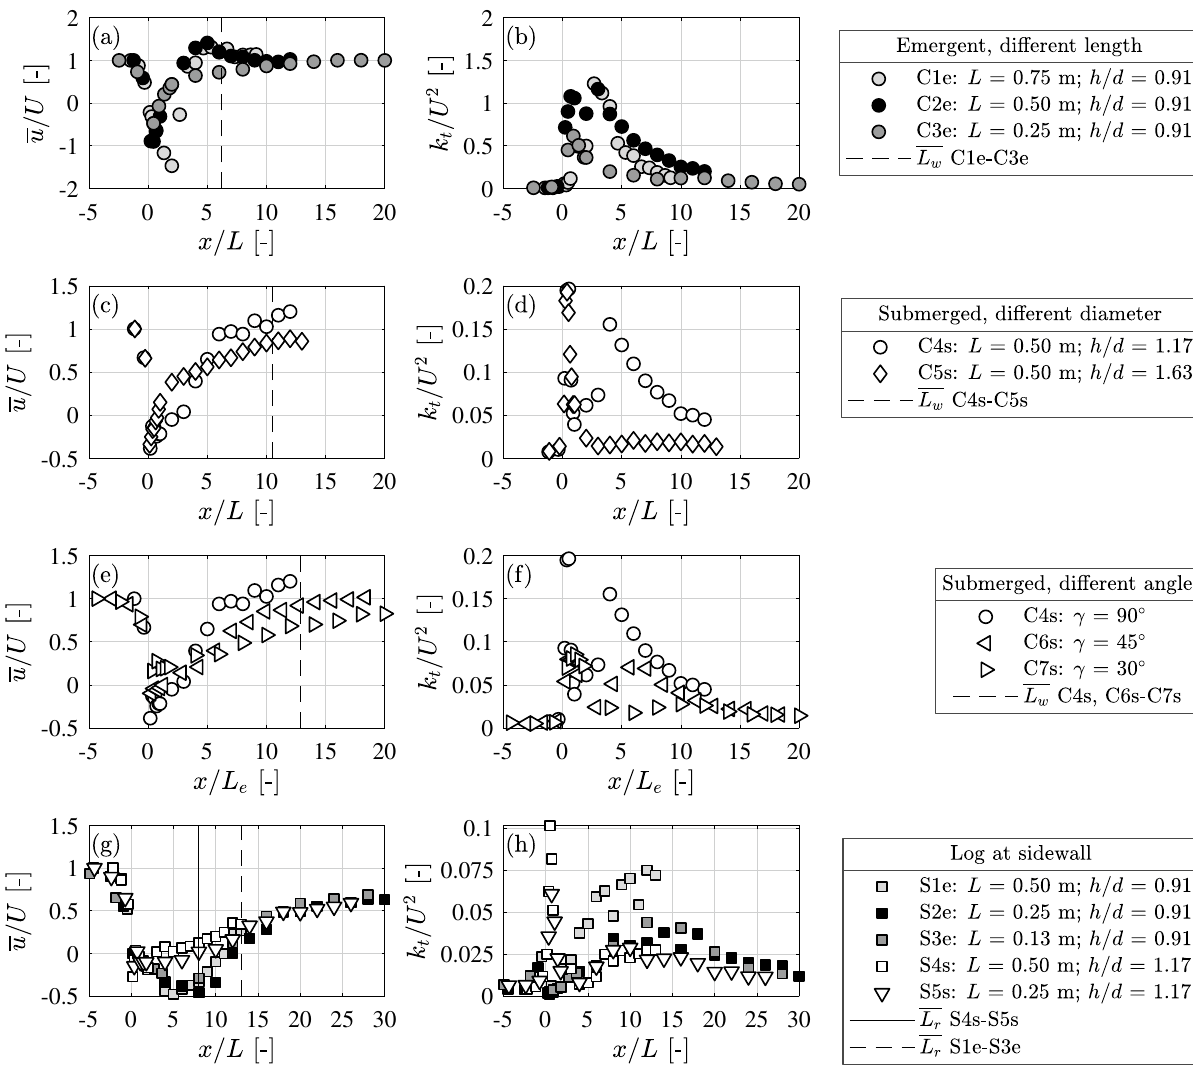
Figure 5. Longitudinal profiles of normalized time-mean velocity and turbulent kinetic energy along log centerline. ( a ), ( b ), and ( c ) logs positioned at the channel center and ( a ) emergent logs of different length, ( b ) submerged logs of different diameter and relative submergence, h / d , ( c ) submerged logs with different log angle. L e is the projected log length. ( d ) Emergent and submerged logs positioned at the sidewall. Vertical lines mark the average wake length, L w , for tests C1-7 and average length of reattachment zone, L r , for tests